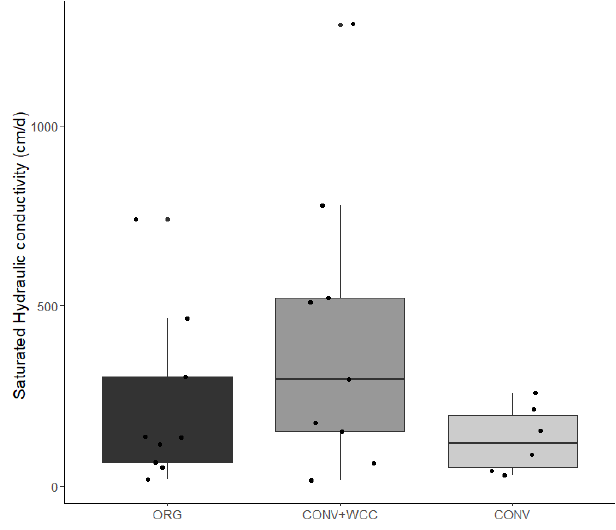
Figure 5. Saturated hydraulic conductivity (cm/day) in ORG, CONV + WCC, and CONV systems taken in August